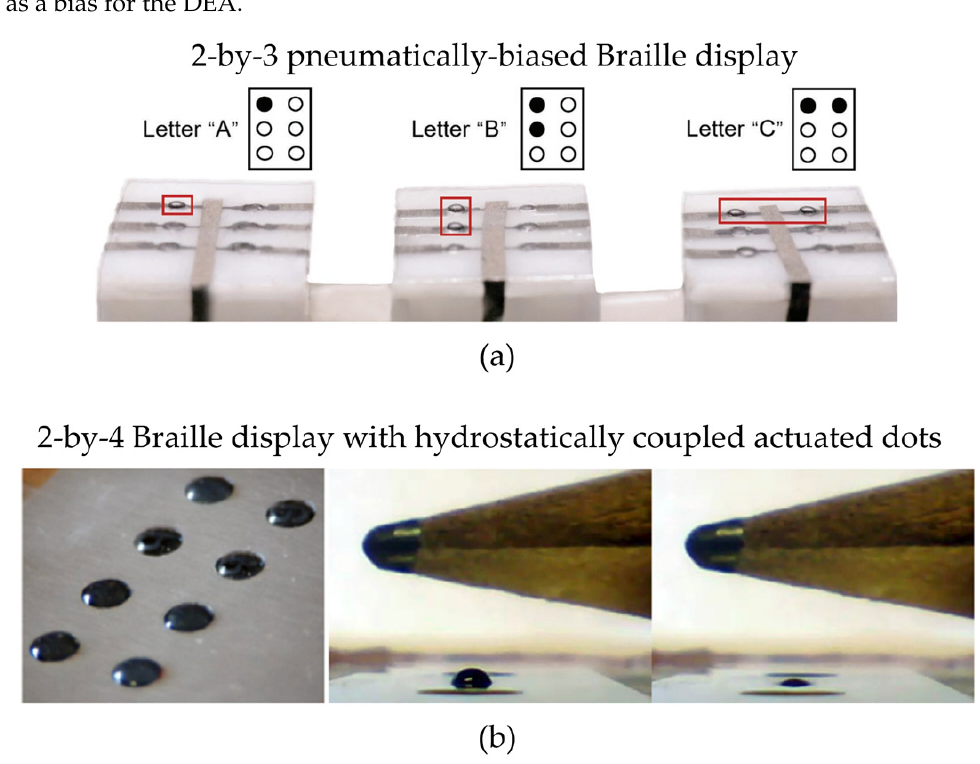
Figure 13. Examples of two-dimensional DEA arrays for refreshable Braille displays: ( a ) 2-by-3 pneumatically biased Braille display [154], reproduced with permission from John Wiley and Sons, copyright 2020; ( b ) 2-by-4 Braille display with hydrostatically coupled actuated dots [155], reproduced with permission from Elsevier, copyright 2018.